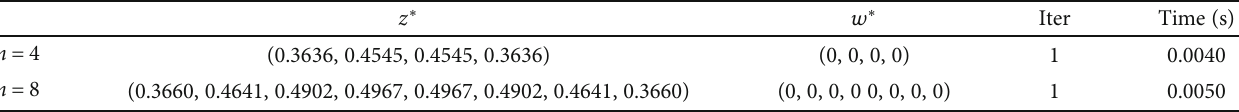
Table 1: Numeric outcomes of our method.